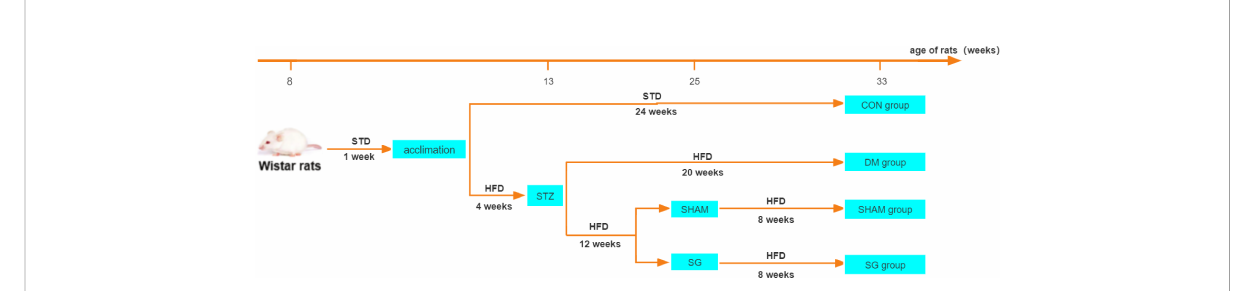
FIGURE 1 Flowchart of animal experiments. N = 10 for each group. STD, standard diet; HFD, high-fat diet; STZ, streptozotocin; CON, control group; DM, diabetes mellitus; SHAM, sham operation; SG, sleeve